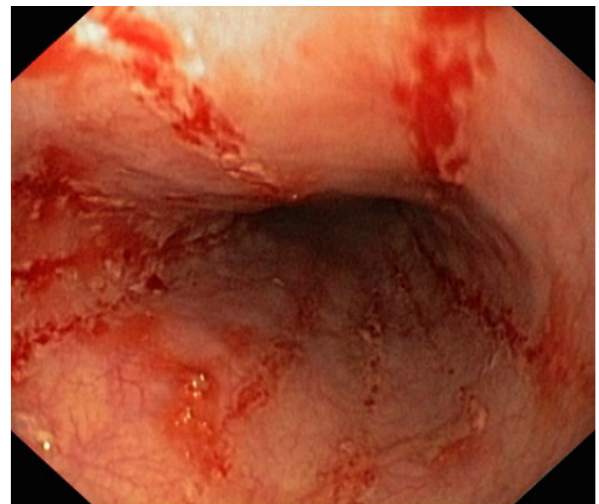
Fig. 1. Pill-induced